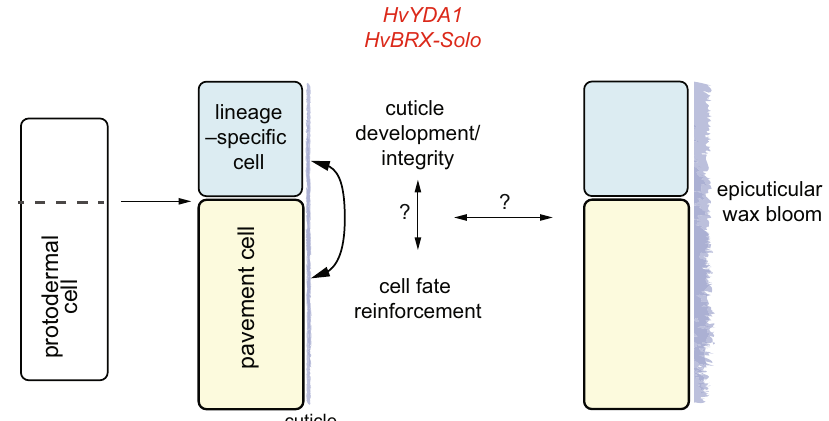
Fig. 7 | ModelHvYDA1 and HvBRX-Solo functionsin barleyepidermalfeatures. During epidermal development, protodermal cells undergo an asymmetric cell divisiontogenerateaspecialisedcellspeci fi ctothecell fi leidentity(stomata,silica, prickle hair) and an epidermal pavement cell. HvYDA1 and HvBRX-Solo proteins reinforce asymmetric cell fate dictated by the lineage cues to prevent specialised fate in the epidermal pavement cell. HvYDA1 and HvBRX-Solo also control the cuticlepropertiesinepidermaltissues.Bothcellfate andcuticle development may